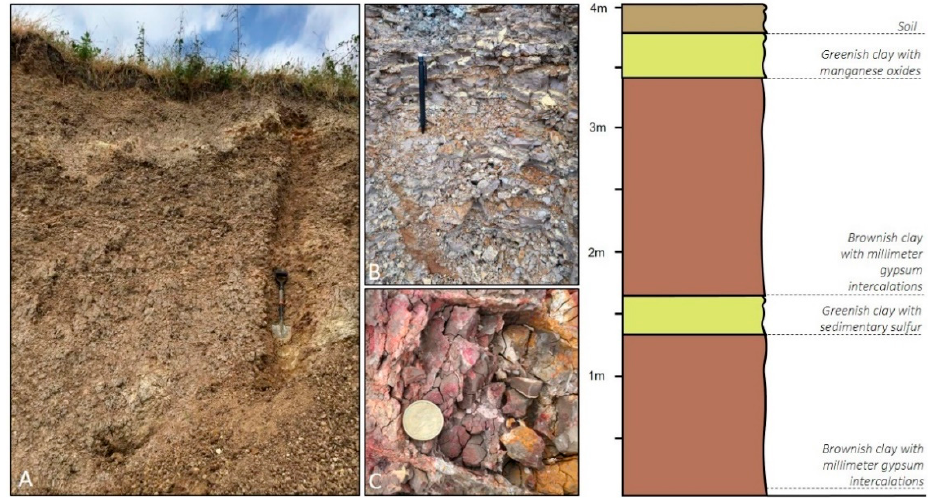
Figure 2. Outcrop ( A – C ) and geological column of the natural clays, iron, and manganese oxides that can be observed in some areas of the study area, the Dos Bocas formation, Santa Elena province,